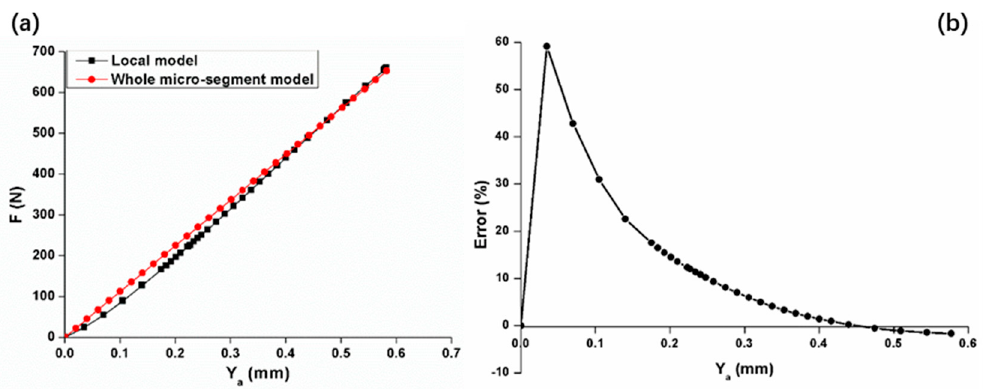
Figure 5. ( a ) F — Y a of the whole microsegment model and the local model, and ( b ) the error of the whole